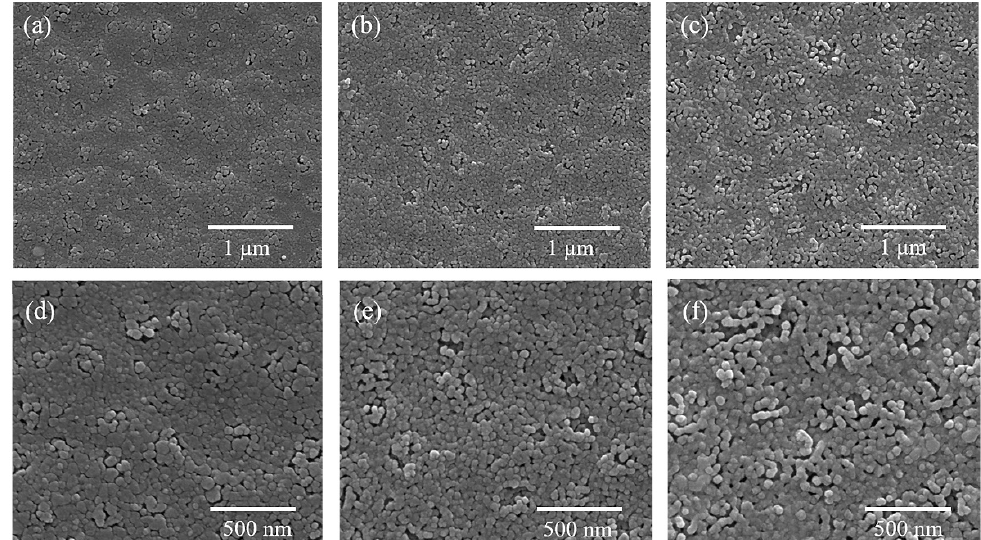
Figure 4. The microstructures of the In-doped LLZO–LZO samples annealed at ( a , d ) 600 °C, ( b , e ) 700 °C, as well as ( c , f ) 800 °C (sample #600-IL, #700-IL, and #800-IL, respectively).